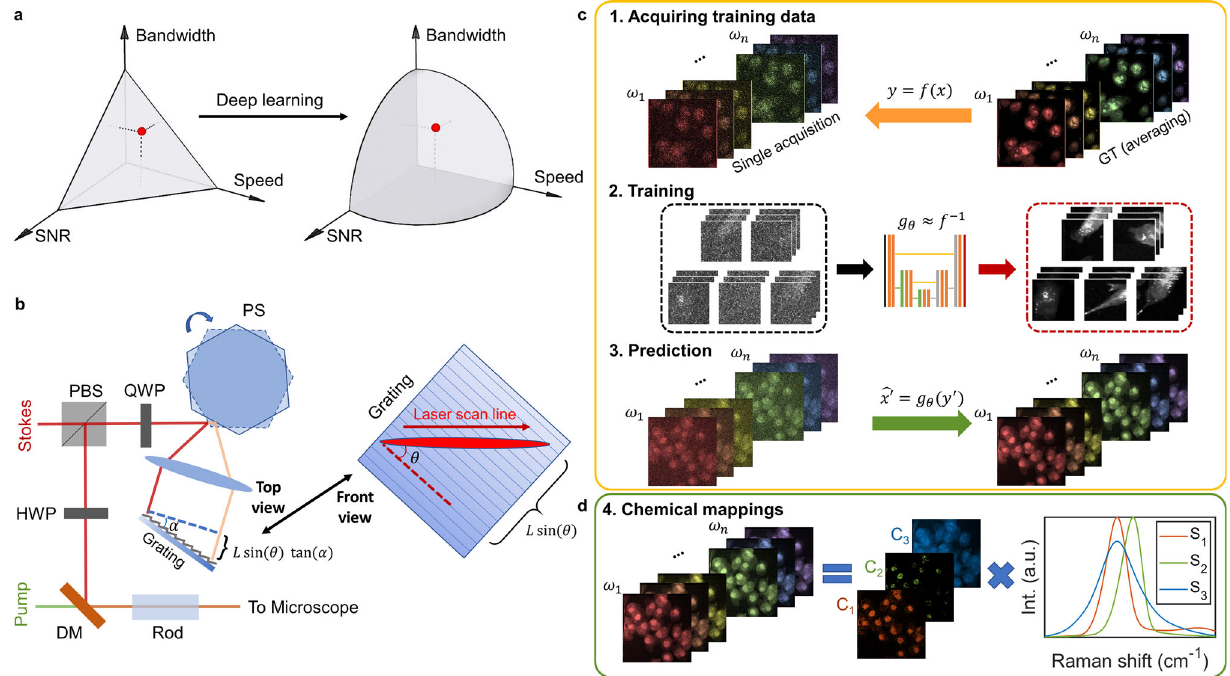
Fig. 1 Overview of fi ngerprint SRS microscopy by ultrafast tuning and spatial-spectral residual learning. a The intrinsic cross-section of the coherent Raman scattering process and instrumentation de fi ne the conventional design space for SRS imaging, resulting in trade-offs between bandwidth (i.e., spectral resolution), speed, and signal-to-noise ratio (SNR). Deep learning can expand the design space through computational methods, enabling high- speed, high-SNR fi ngerprint SRS imaging of living cells and large-area tissues. b Setup of ultrafast delay-line tuning. A 55-kHz polygon scanner is used to scan the Stokes beam onto a Littrow-con fi gured blazed grating to generate an SRS spectrum within 20 µ s. By changing the angle between the grating blazed line and the laser-scanned line ( θ ), the effective delay range can be fi ne-tuned as L sin( θ )tan( α ), where α represents the grating blazed angle and L is the length of laser scan line. PBS polarizing beam splitter, QWP quarter-wave plate, HWP half-wave plate, PS polygon scanner, DM dichroic mirror. c Training a spatial-spectral residual net (SS-ResNet) deep neural network for SNR improvement, ground truth (GT) images are generated by averaging multiple acquisitions of the same fi eld-of-view, equivalent to increasing the pixel dwell time. A trained network is then applied to recover the SNR of high- speed yet noisy images. d Spectral unmixing using least absolute shrinkage and selection operator (LASSO) to generate chemical maps. Int., intensity. a.u., arbitrary